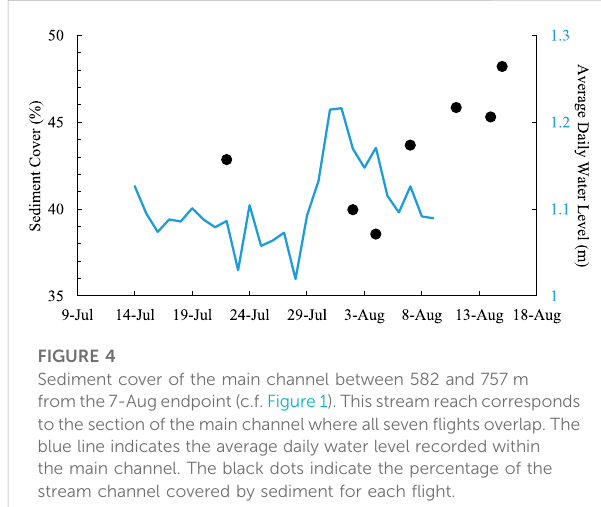
FIGURE 4 Sediment cover of the main channel between 582 and 757 m fromthe7-Aug endpoint(c.f.Figure 1).Thisstream reachcorresponds to the section of the main channel where all seven fl ights overlap. The blue line indicates the average daily water level recorded within the main channel. The black dots indicate the percentage of the stream channel covered by sediment for each fl